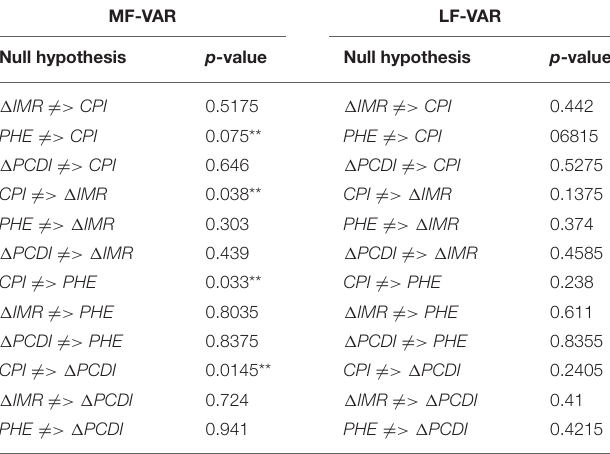
TABLE 3 | Granger causality